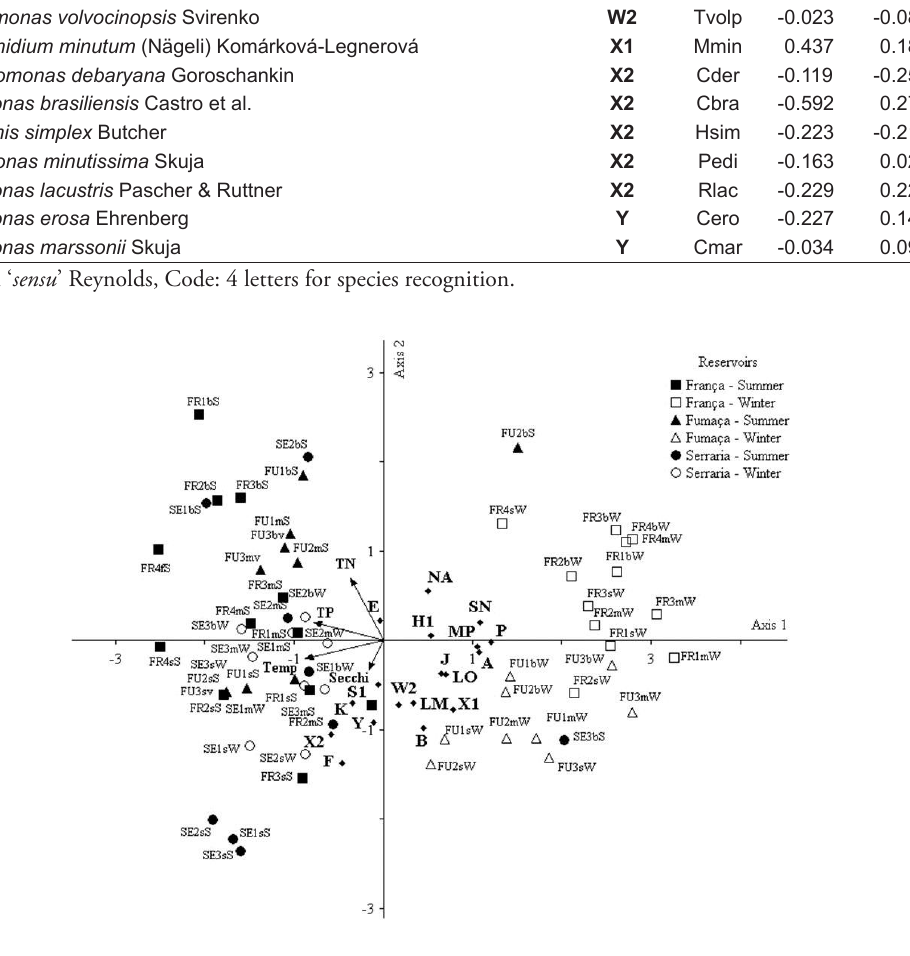
Figure 6. RDA codons ordination (‘ sensu ’ Reynolds) and 4 abiotic variables at Cachoeira do França (FR), Cachoeira da Fumaça (FU) and Serraria (SE) reservoirs. Abbreviations: capital letters indicate reservoir (FR Cachoeira do França, FU Cachoeira da Fumaça, SE Serraria), number indicates sampling site (1, 2, 3, 4), lowercase letter indicates sampling depth (s subsurface, m intermediate layer, b 1 m above bottom) and last capital letter the climatic season (S Summer, W Winter). Vectors: Secchi Disk, Temp Temperature, TP Total Phosphorus, TN Total